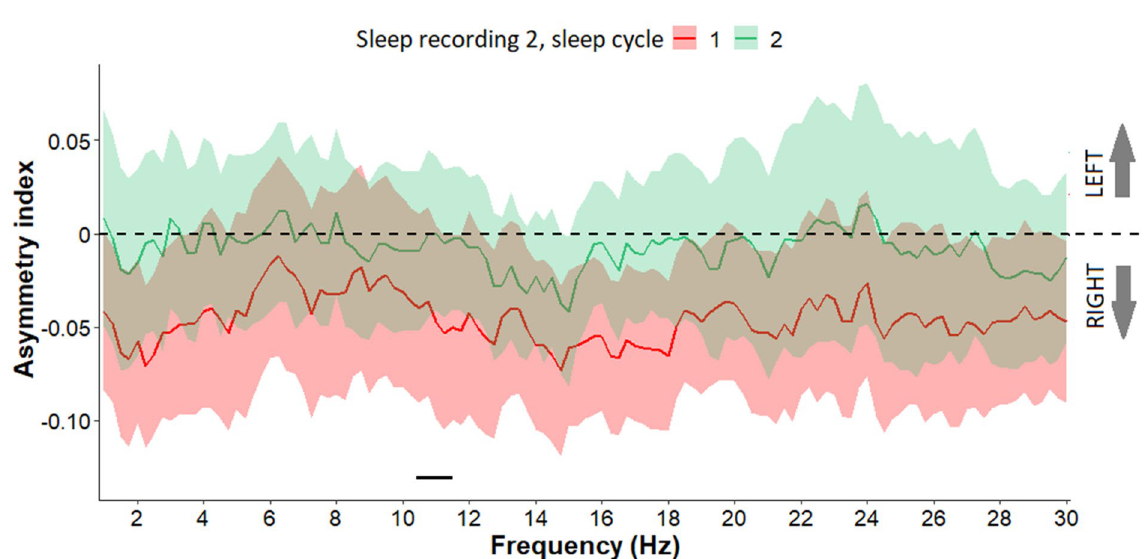
Figure 4. Asymmetry index values (Mean + / − SE) in frequency range 1–30 Hz in the first and second sleep cycle of sleep recording 2. In the first sleep cycle in frequency range of 10.5–11.5 Hz greater rightward asymmetry was observed, compared to the second sleep cycle of sleep recording 2. Frequency bins below the statistical threshold (all p s < 0.05, fulfilling the criteria of a significant Rüger area) are illustrated by a black horizontal